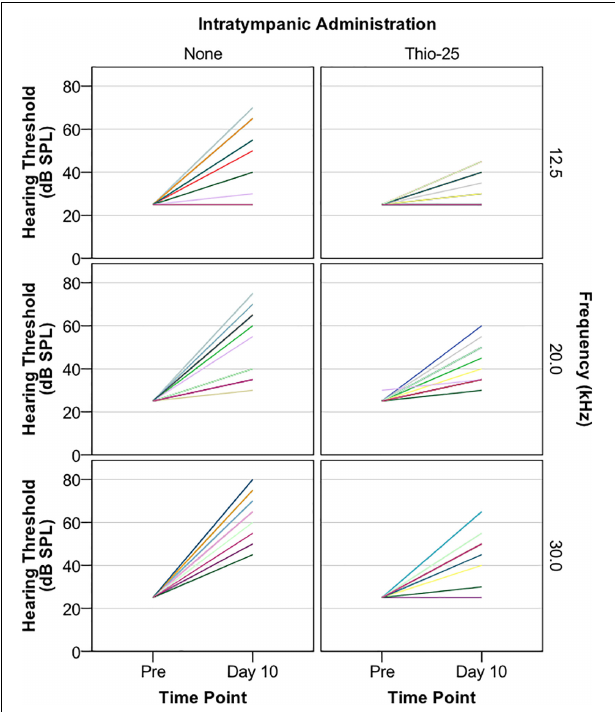
FIGURE 2 | Guinea pigs were subjected to a single, unilateral IT injection of a sodium thiosulfate-containing chitosan-based gel (Thio-25, n = 15), while the other ear was left untreated, serving as a control (None). The animals received a single high dose of cisplatin (8 mg/kg b.w., i.v.) 1 h later. Electrophysiological hearing thresholds (in decibel sound pressure level, dB SPL) assessed with air-conducted acoustically evoked auditory brainstem response (ABR) at 12.5, 20, and 30 kHz before and 10 days after IT administration are shown. Each color represents one animal. Fewer colors than 15 per graph are due to overlapping lines.